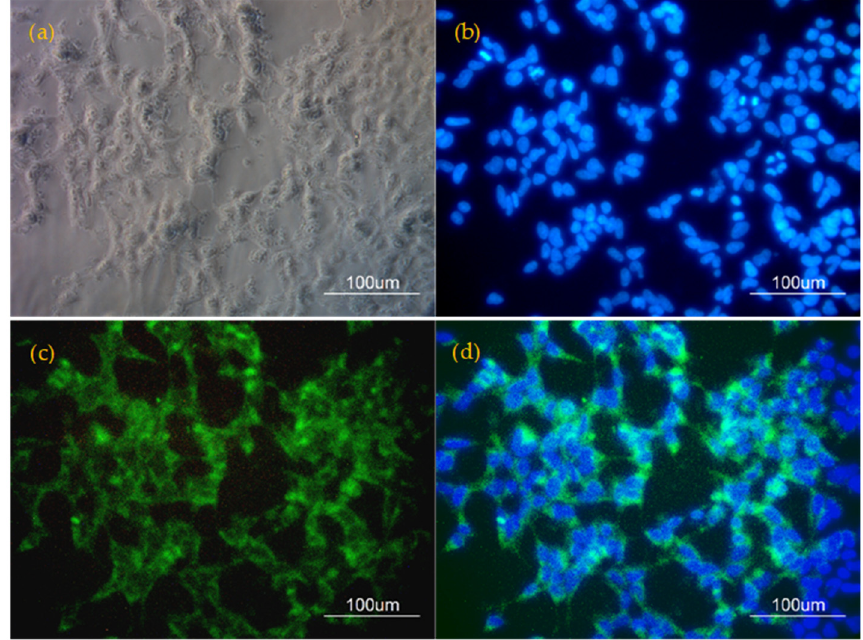
Figure 2. Immunohistochemistry (IHC) images of ( a ) optical, ( b ) DAPI-staining, ( c ) anti-insulin staining, and ( d ) merge of ( b ) and ( c ) in HEK-293T cells treated with MPIPs/dCas9-VPR and crRNA.